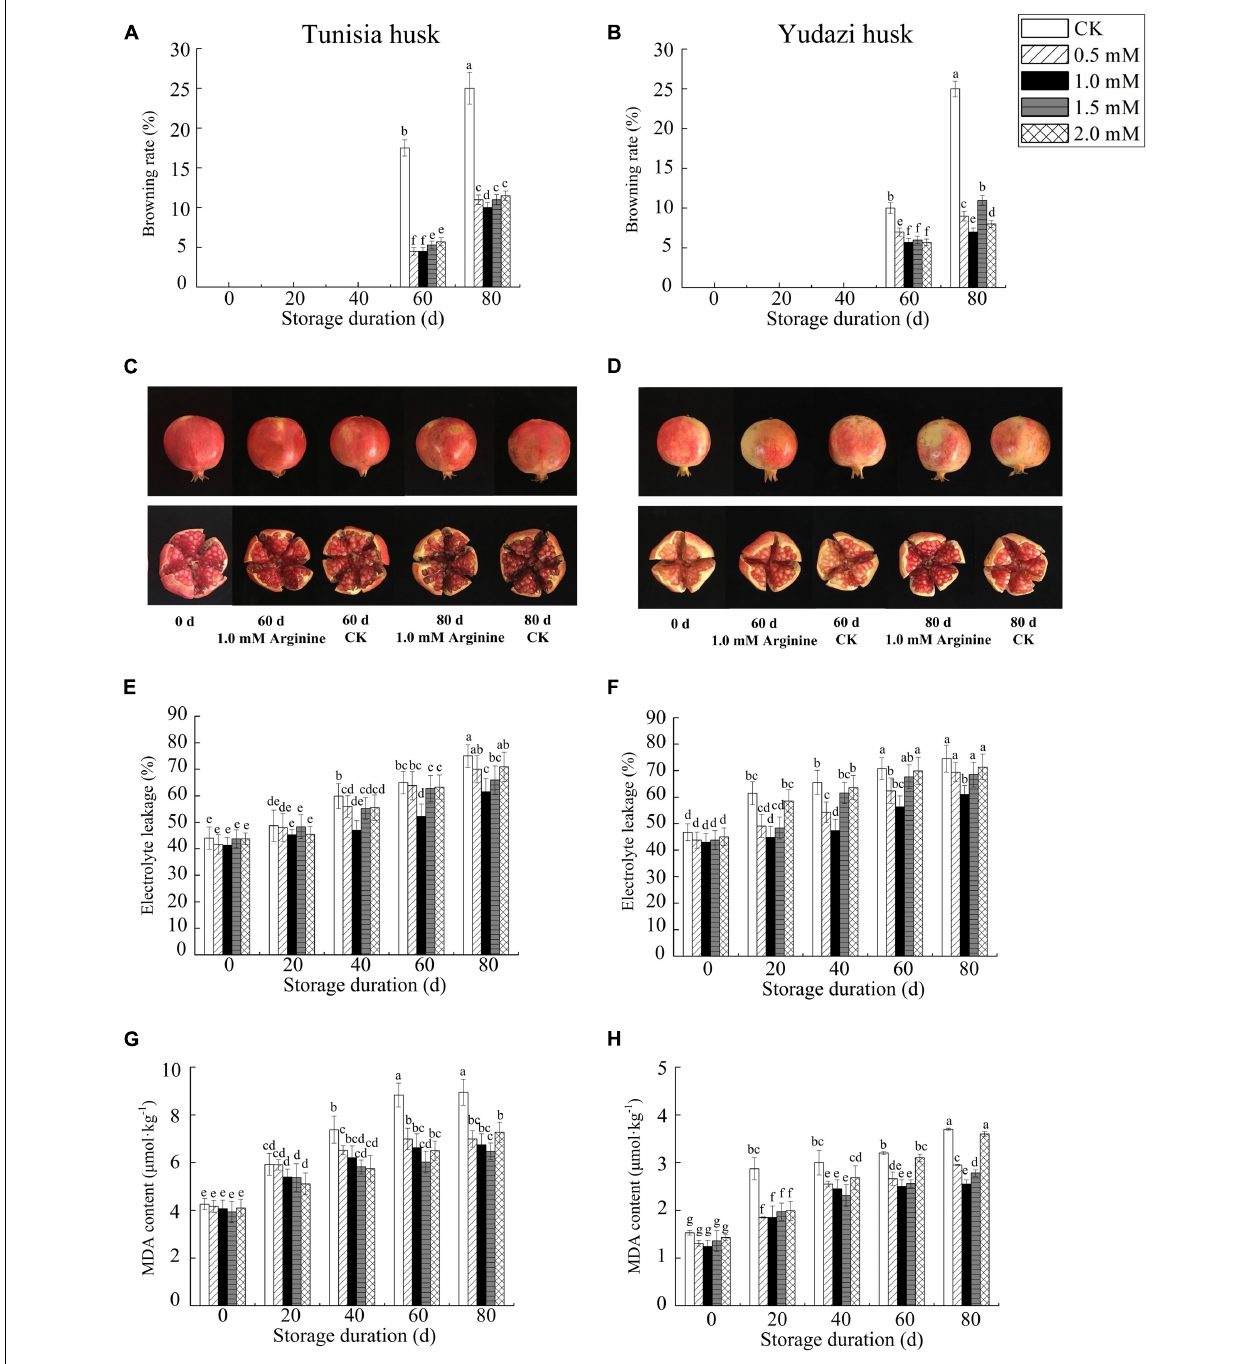
FIGURE 1 | Effect of arginine treatment on browning rate, electrolyte leakage, and MDA content in pomegranate husks during cold storage at 4 ± 0.5 ◦ C. Panels (A,C,E,G) present Tunisia fruit data. Panels (B,D,F,H) present Yudazi fruit data. Values are presented as the mean ± standard error of triplicate samples. Different letters indicate significant differences among concentration treatments and sampling dates during the cold storage at P <